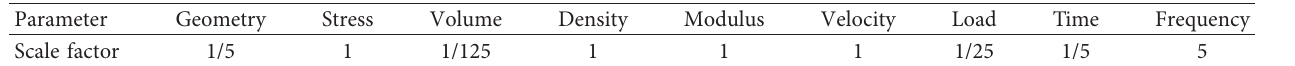
Table 2: Model test scale